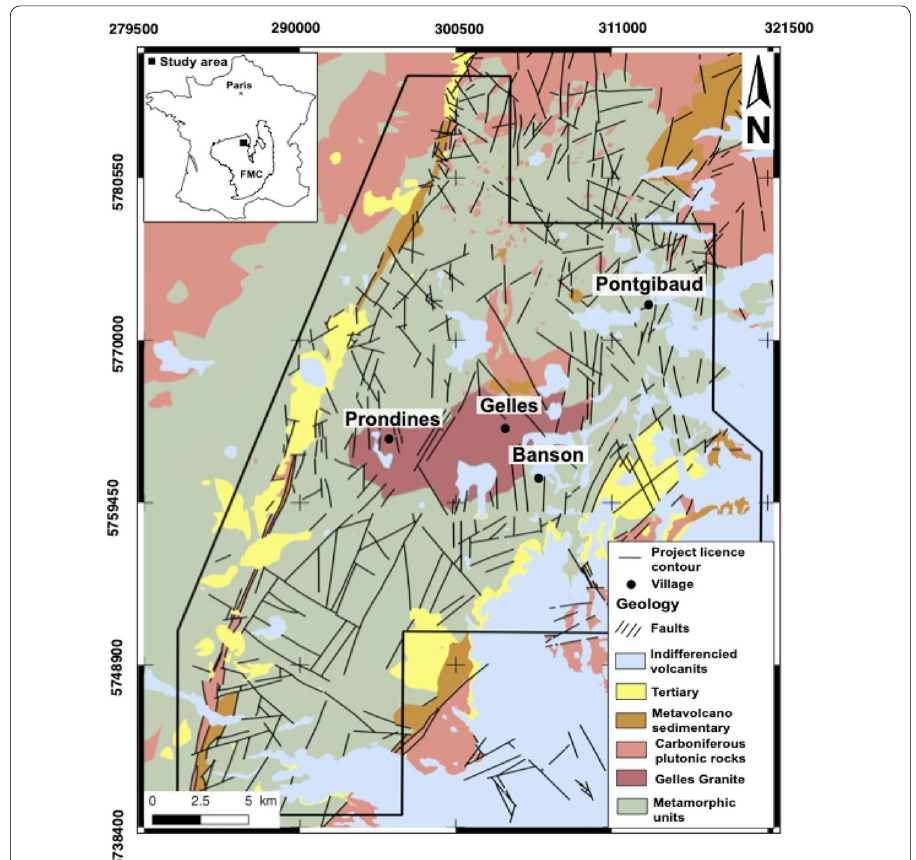
Fig. 1 Simplified geological map showing the “La Sioule” licence area (black contour) and a brief overview of the major stratigraphic units in the study area. French Massif Central (FMC). Coordinate system: WGS84 Pseudo‑Mercator EPSG:3857 (After the 1/50,000th geological map published by